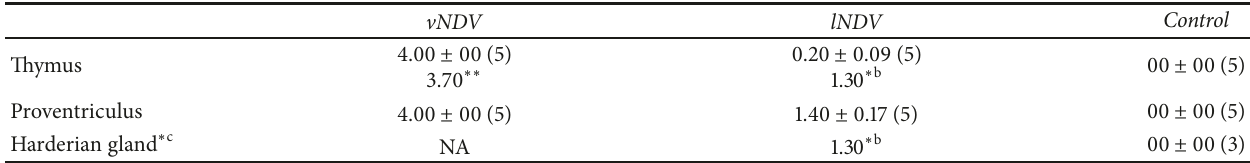
Table 10: Lesions scoring (0-4) induced by velogenicand lentogenicNDVstrains in HE stained thymus, proventriculus,and Harderian gland tissues on day 5 pi.